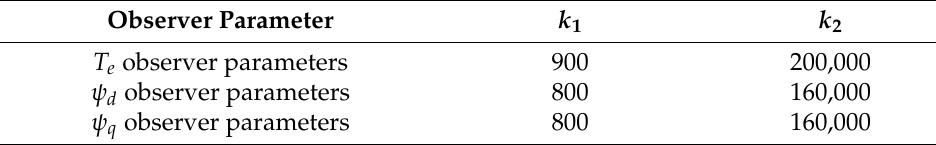
Table 2. Observer